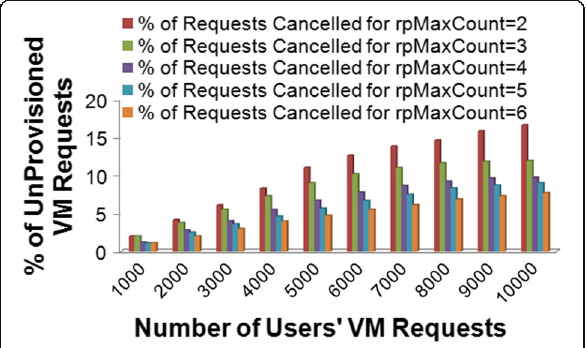
Fig. 8 Un-provisioned Users ’ VM Request (in %) w.r.t different rpMaxCount